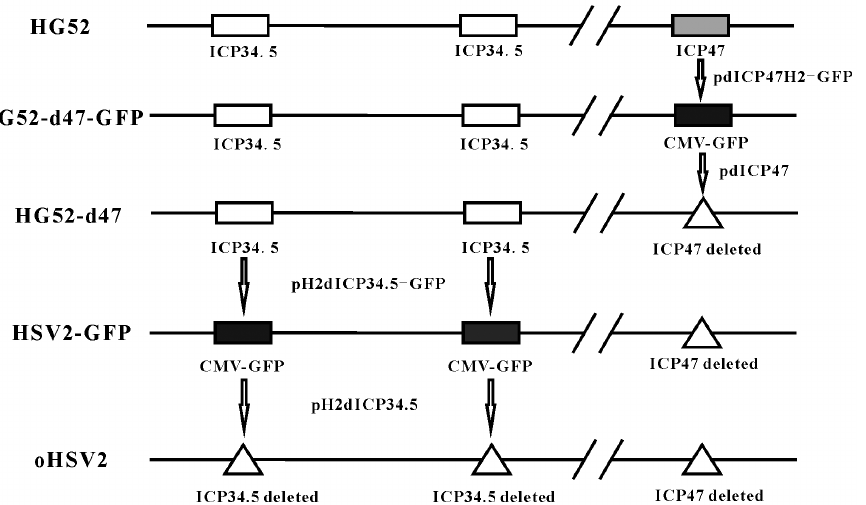
Figure 1. Schematic of the construction of oncolytic HSV2-GFP and HSV2. The two oncolytic HSV2 vectors were developed from the HG52 strain. Modifications include deletion of the ICP47 and ICP34.5 genes and insertion of a GFP expression cassette.